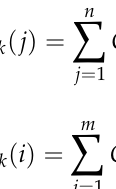
Figure 5. Pixel movement caused by shakiness.